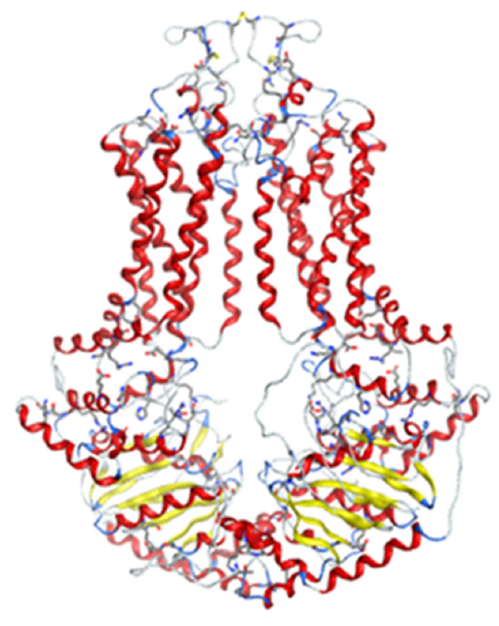
Figure 5. Homology model of ABCG2.